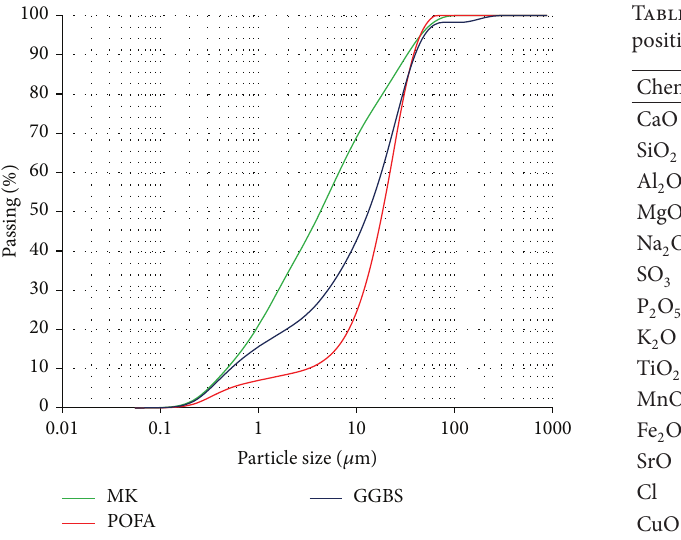
Figure 3: MK, GGBS, and POFA’s particle size distribution (log scale).